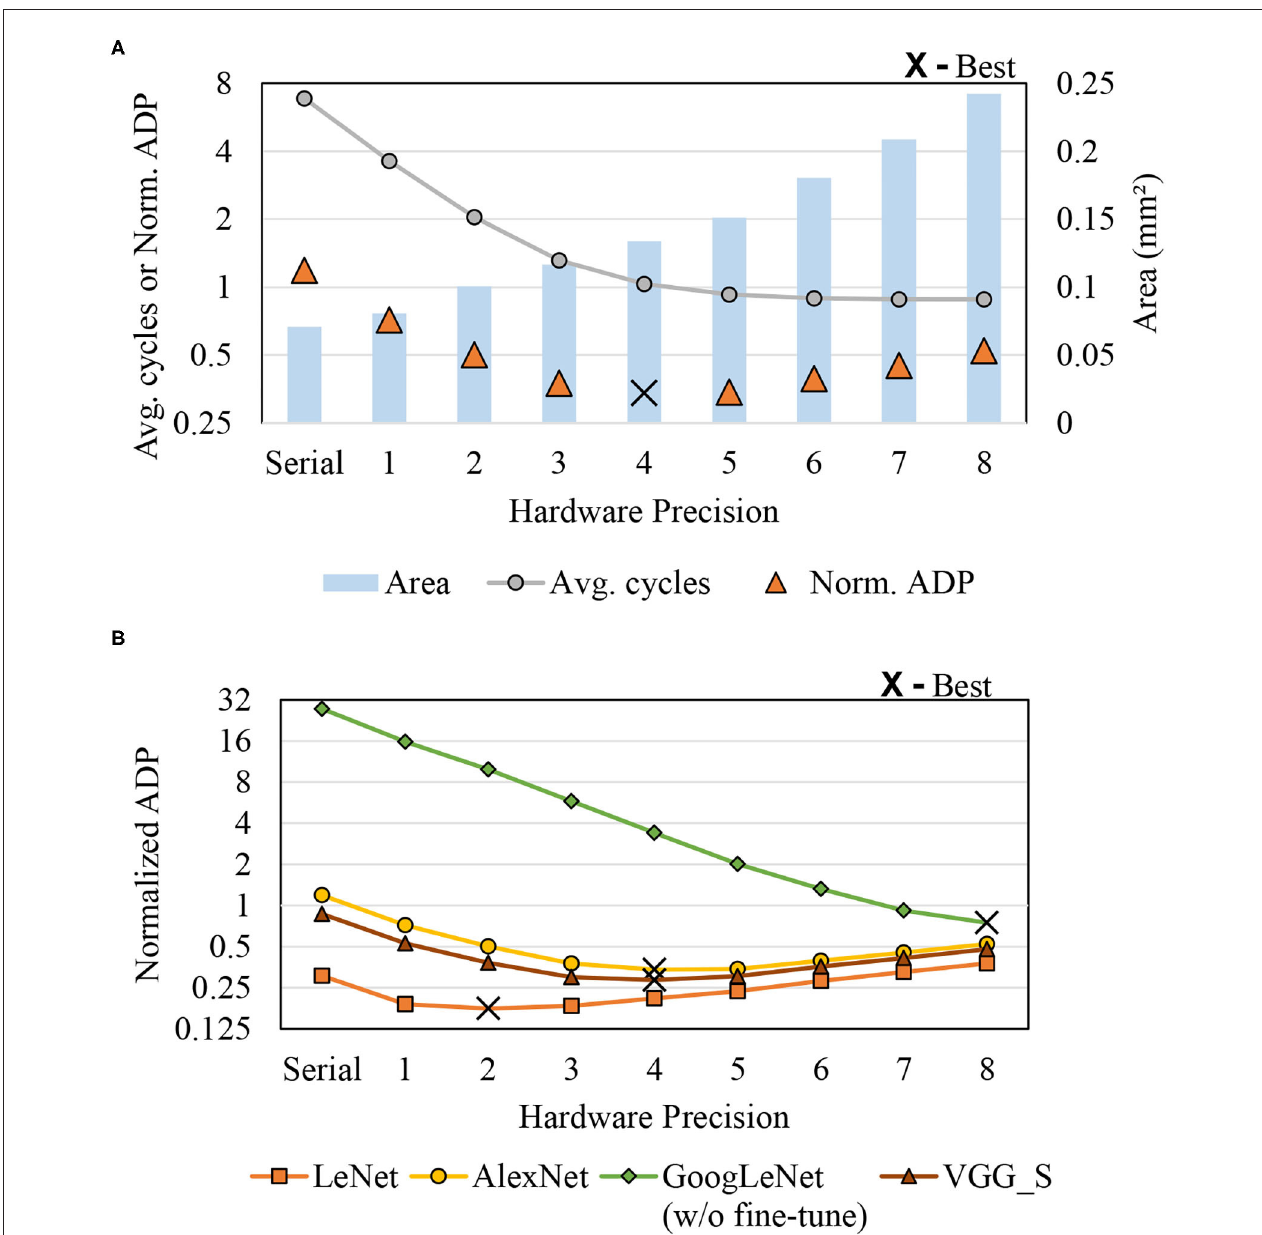
FIGURE 8 | Area-delay product (ADP) vs. hardware precision. (A) AlexNet and (B) Multi-application.